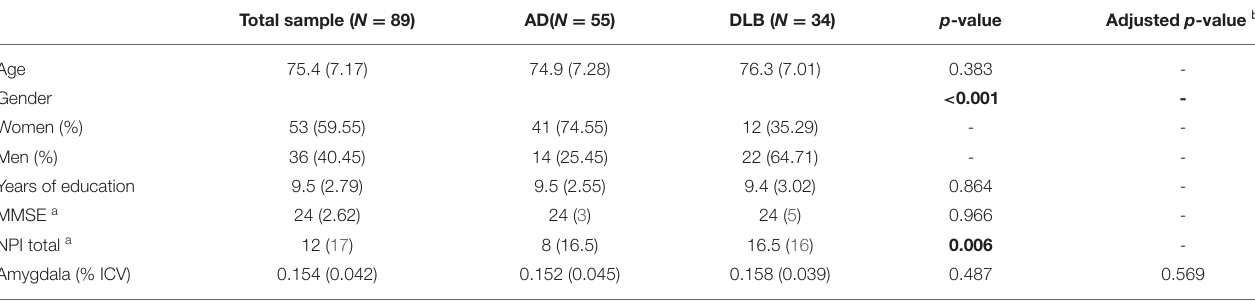
TABLE 1 | Baseline characteristics of the AD and DLB